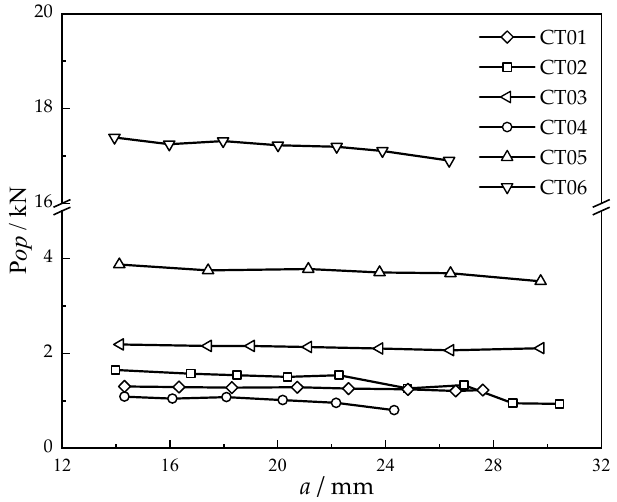
Figure 7. Crack opening force of CT specimens under different loading conditions.